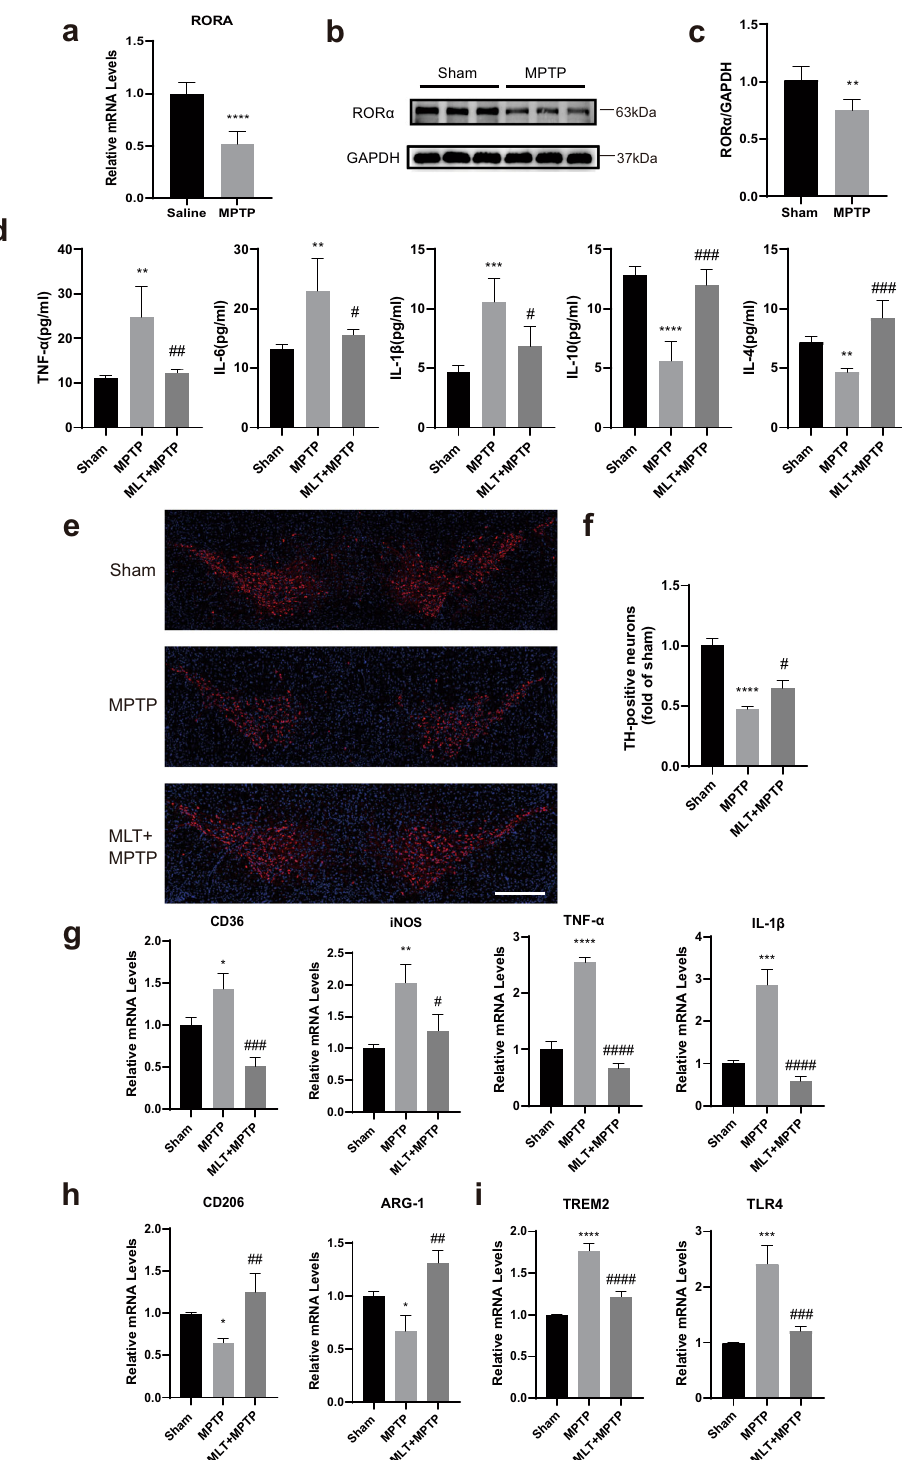
Fig. 3 Expression of ROR α was decreased in MPTP-treated mice and MLT showed an anti-in fl ammatory effect to attenuate MPTP. The mice were treated with MPTP (25 mg/kg, i.p.) or pre-treated with MLT (20 mg/kg, i.p.) half an hour before MPTP injection for 7 days. The levels of ROR α in midbrain tissues were measured a week after the behavioural tests. a Relative mRNA levels of ROR α were measured by RT-qPCR. b , c Protein levels of ROR α , normalized to GAPDH. d ELISA results indicated the serum levels of TNF ‐ α , IL ‐ 6, IL ‐ 1 β , IL-4 and IL ‐ 10. e Representative immuno fl uorescent staining images of TH in SN. Blue indicates nuclei. TH were labeled as red. Scale bars = 500 μ m. f The number of TH + cells in midbrain (represented as fold of sham). g mRNA quanti fi cation of pro-in fl ammatory (M1-like) phenotype markers (CD36, iNOS, TNF- α , IL-1 β ) in midbrain tissue by RT-qPCR. h mRNA quanti fi cation of anti-in fl ammatory (M2-like) markers (CD206, ARG ‐ 1) in midbrain tissue. i mRNA quanti fi cation of DAM phenotype markers (TREM2, TLR4) in midbrain tissue. Data were average with error bars representing standard deviation. ( n = 5 per group. *, # P < 0.05; **, ## P < 0.01; ***, ### P < 0.001; ****, #### P < 0.0001; *, vs Sham group; #, vs MPTP